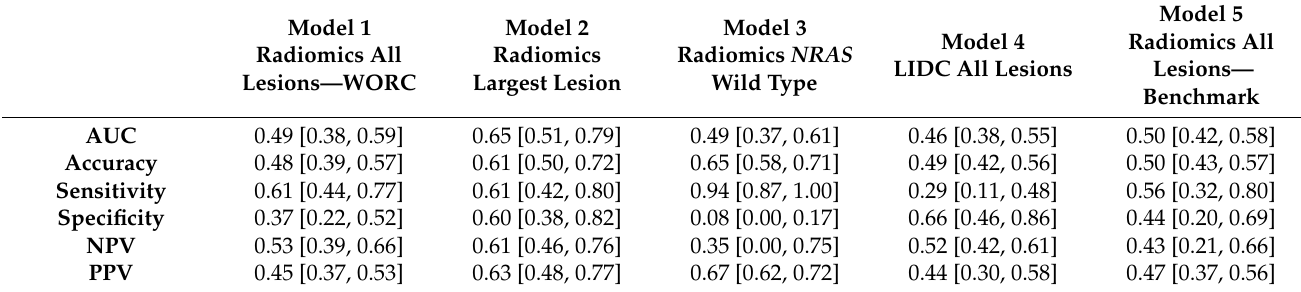
Figure 3. Receiver operating characteristic (ROC) curve of the radiomics model of all lesions ( A ), only the largest lesion ( B ), only BRAF wild type lesions with NRAS wild type ( C ) and LIDC features ( D ). The crosses identify the 95% confidence intervals of the 100 × random-split cross-validation; the blue curve is fit through their means. Table 2. Performance of the models for BRAF mutation prediction based on different sets of features and